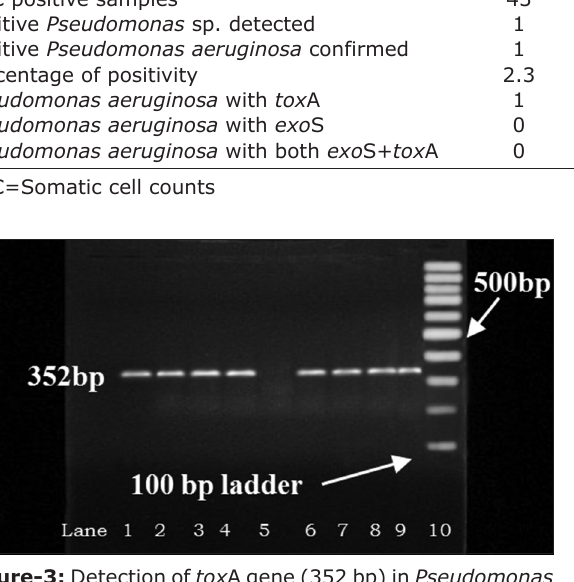
Figure-3: Detection of tox A gene (352 bp) in Pseudomonas aeruginosa isolates by polymerase chain reaction. Lane 2-4, 6-9: Test samples, 1: Positive control, 5: Negative control.